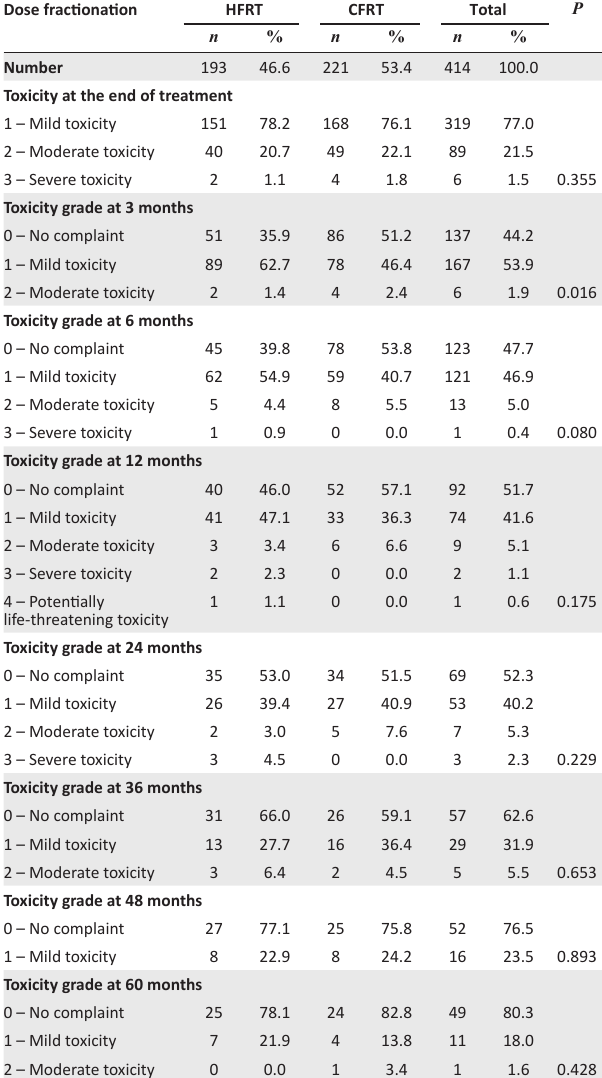
TABLE 2: Summary of response at intra-cavitary and follow-up at different periods. Columns by: Dose (Gy)